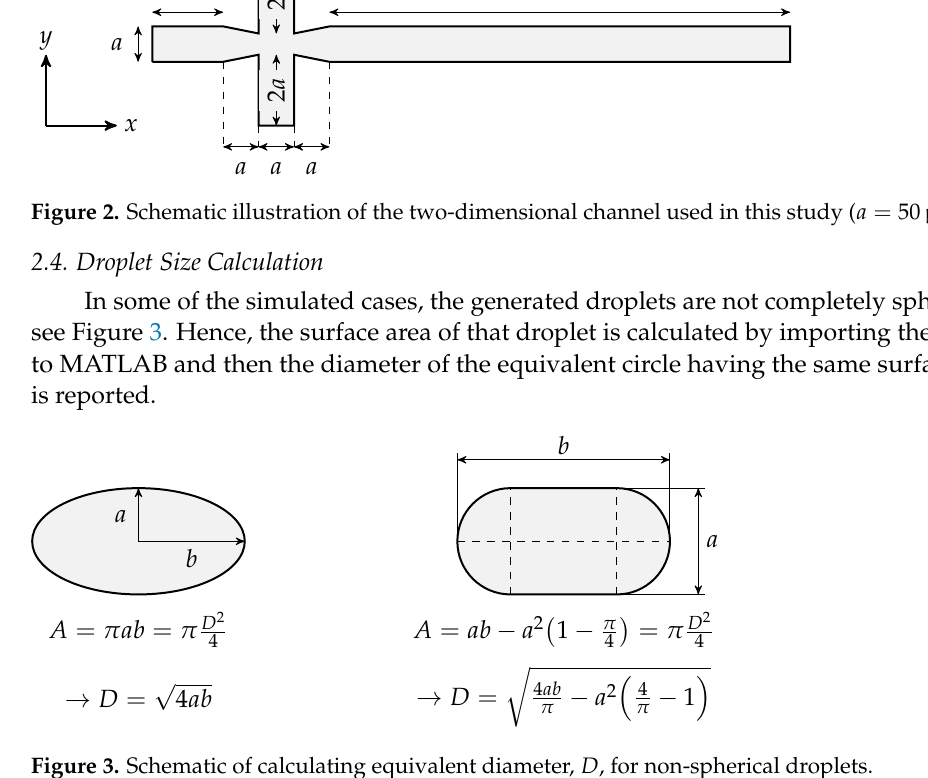
Figure 3. Schematic of calculating equivalent diameter, D , for non-spherical